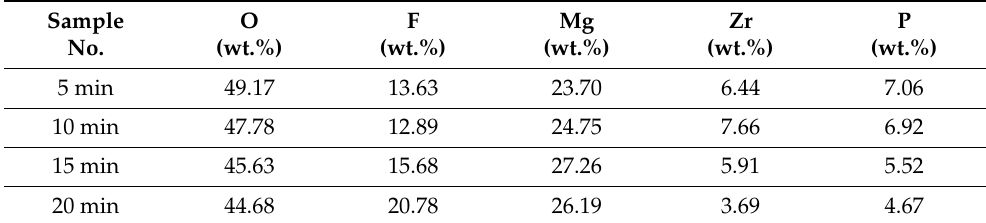
Table 2. EDS analysis data of MAO coating surface at different times.